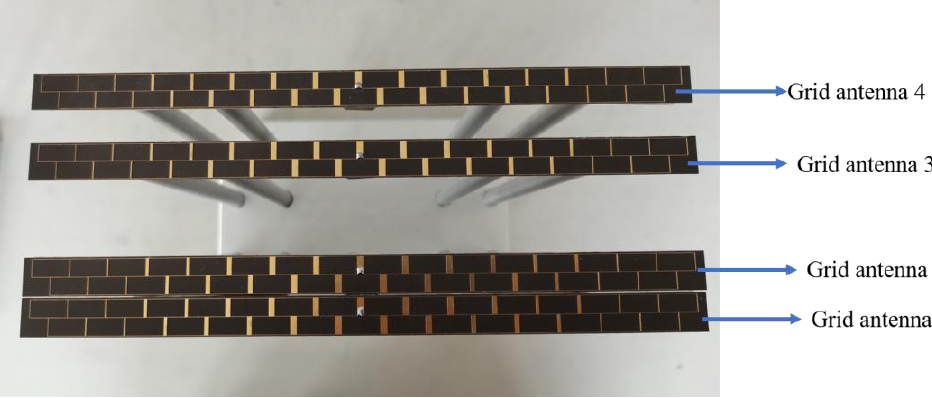
Figure 15. Photograph of the fabricated one-dimensional sparse array by microstrip grid antennas.